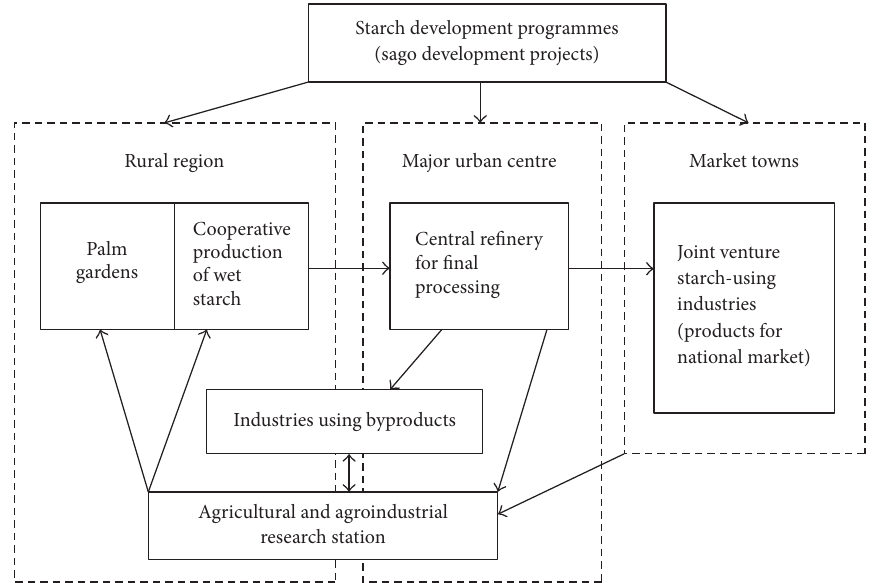
Figure 1: National natural resources development policies and institutions.